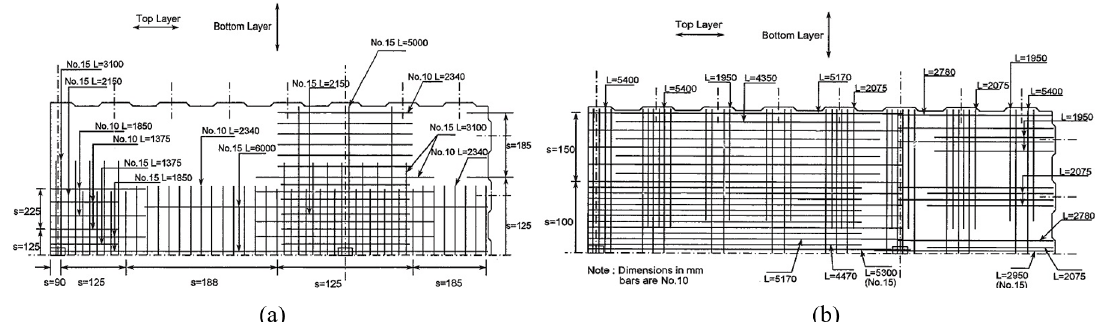
Figure 3. Flexural reinforcement for the specimens tested by Sherif and Dilger [6].